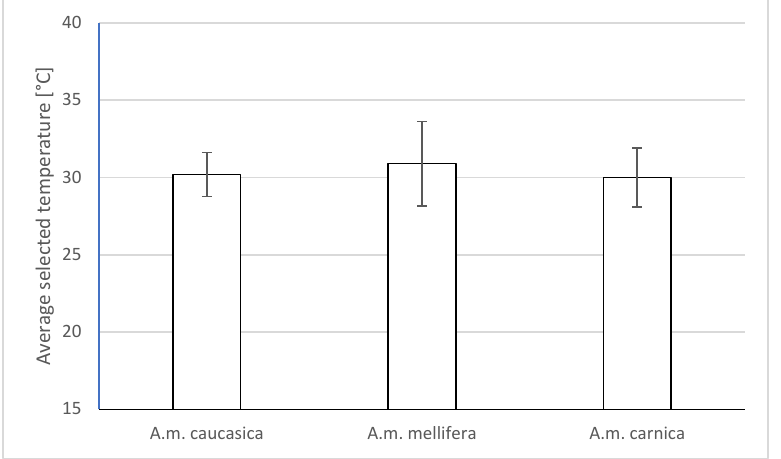
Figure 5. Differences between average temperatures [°C] selected by worker bees from the following subspecies: Caucasian honeybee, Carniolan honeybee and Central European honeybee.